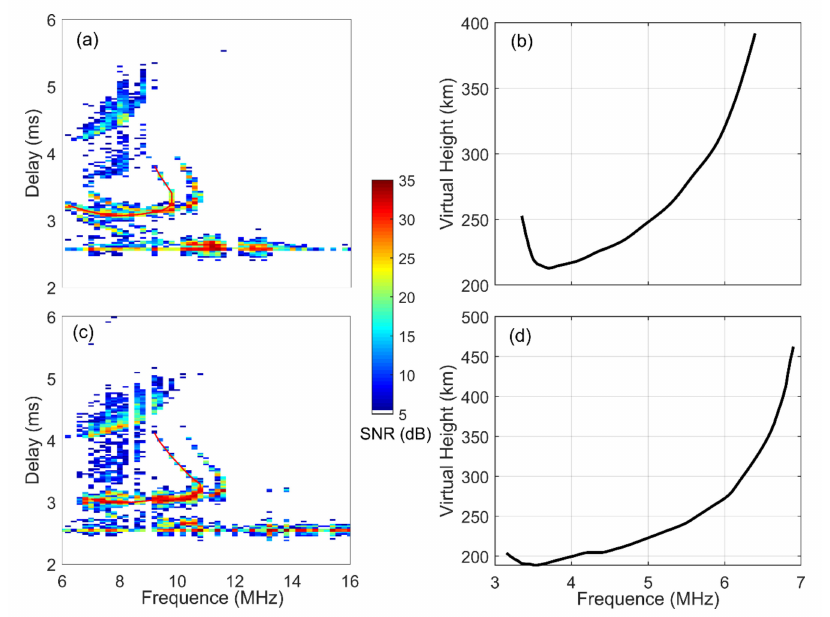
Figure 2. Oblique-incidence ionograms and the corresponding inversed vertical echo traces. ( a , c ) The recorded oblique-incidence ionograms. ( b , d ) The inversed vertical echo derived from the ordinary wave trace that were reflected from the ionospheric F2 layer (red